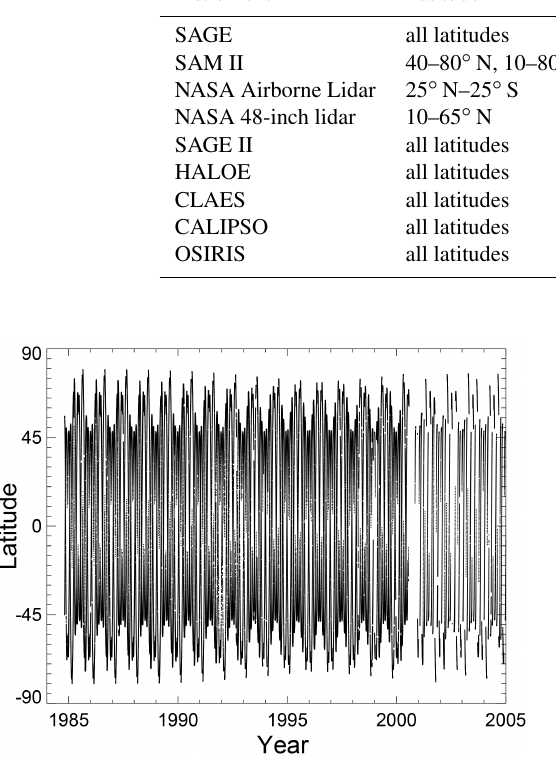
Figure 2. Distribution of SAGE II observations throughout its life- time with one dot per event. From October 1985 to July 2000, there are about 10000 events per year. Due to an instrument fault, there are no events from August to October 2000 and the instrument op- erates on a half duty cycle (a mix of sunrise and sunset events) until the end of its mission in August